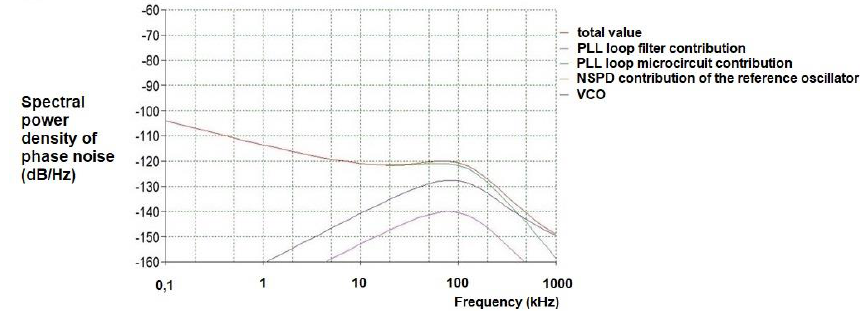
Fig. 7 . The dependence of NSPD value calculated in ADIsimPLL program with offset up to 1 MHz of the oscillator stabilized by the PLL loop with frequency division by